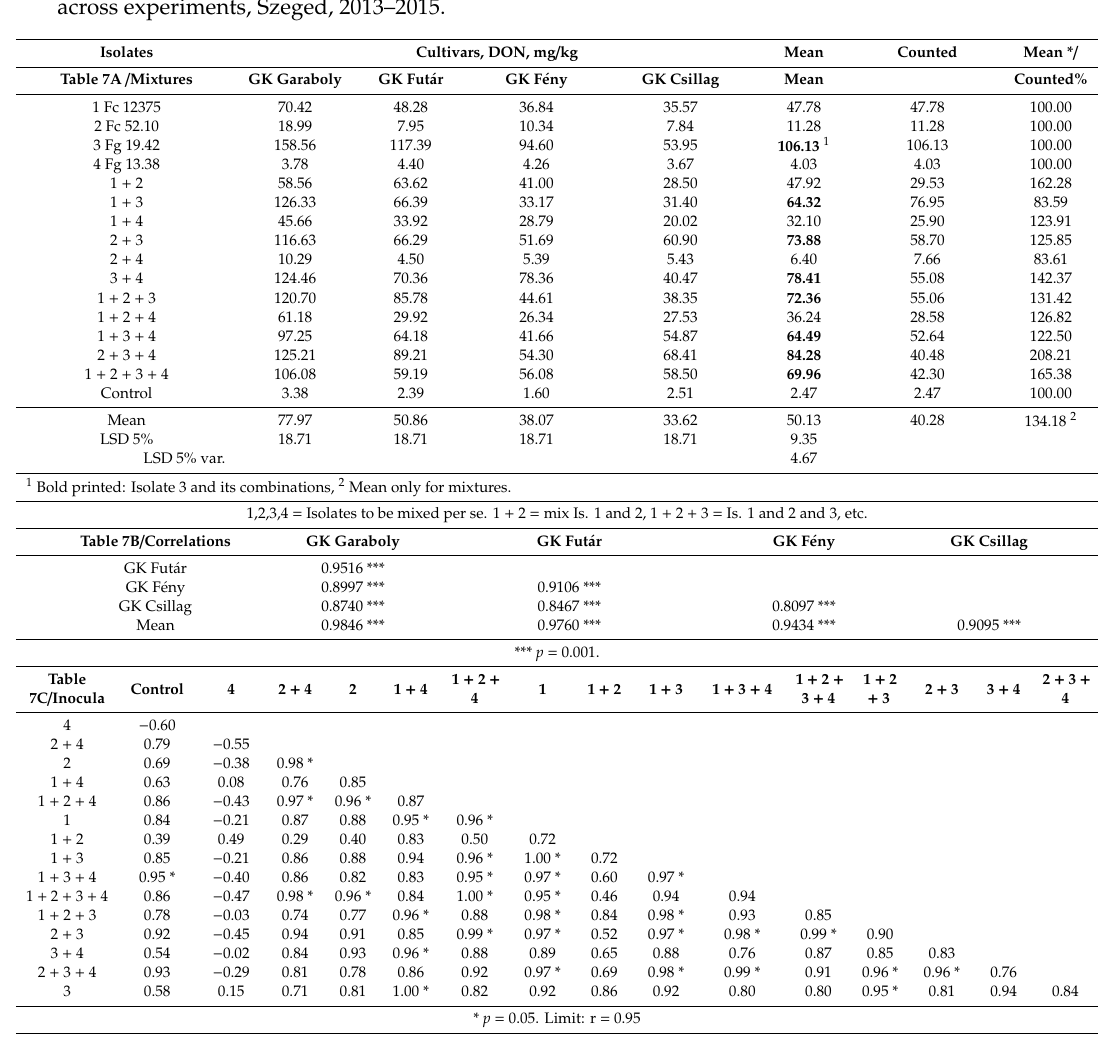
Table 7C / Inocula